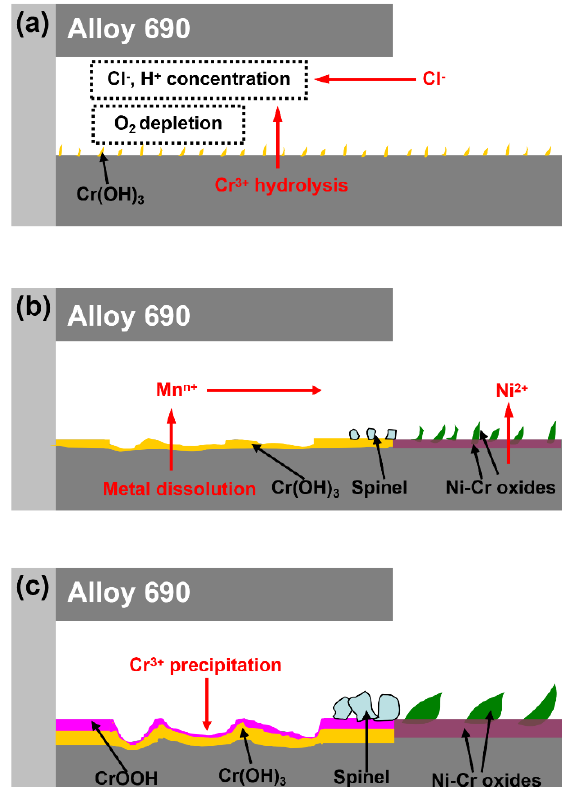
Figure 9. Schematic of crevice corrosion of Alloy 690 exposed to 290 °C NaCl solution. ( a ) initial stage of crevice corrosion ( b ) propagative stage of crevice corrosion ( c ) stable stage of crevice corrosion.